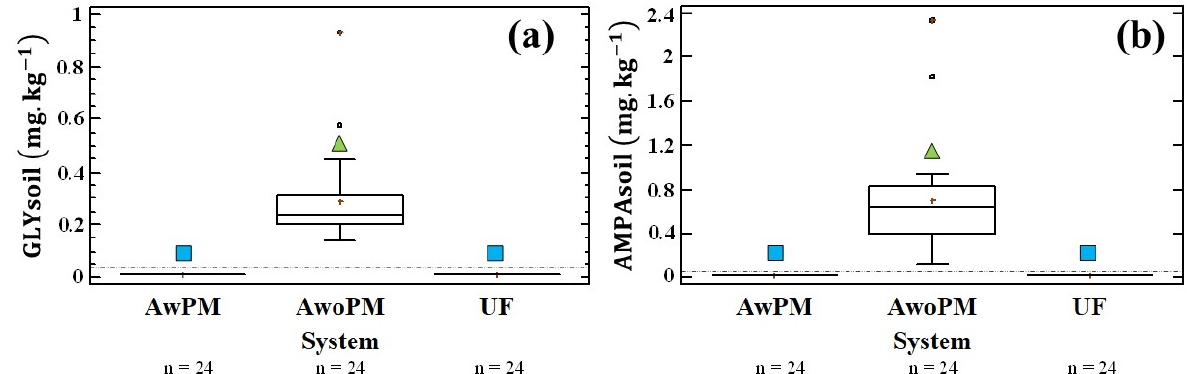
Figure 3. ( a ) Soil GLY concentration (GLYsoil) and ( b ) soil AMPA concentration (AMPAsoil) per system. Each small square indicates an outlier, + = mean, middle horizontal line in the box indicates median, n = number of sampling points for statistical analysis, dotted line indicates the LOD. Different geometric figures implies significantly different groups (Mann–Whitney U test, p < 0.05). AwPM = agriculture with plastic mulch and GLY; AwoPM = agriculture without plastic mulch and the use of GLY; UF = unmanaged farming system.